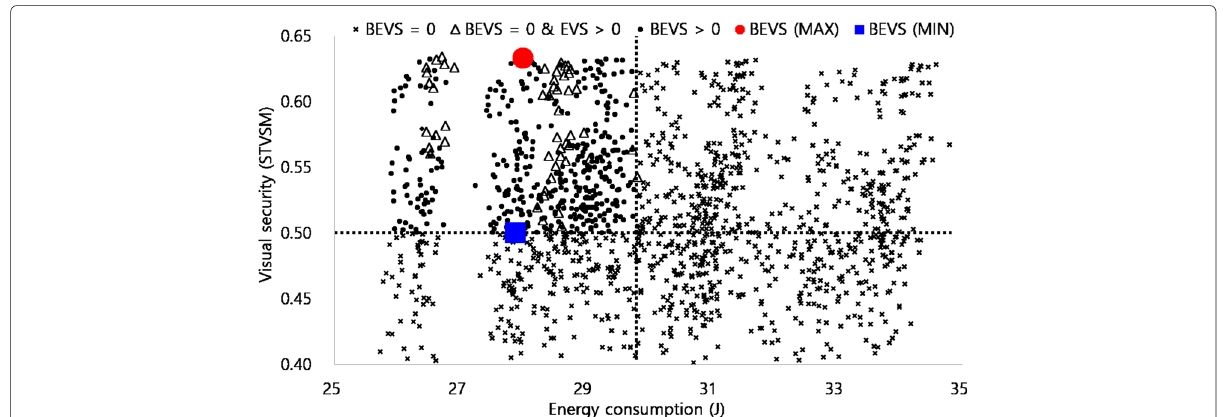
Fig. 7 Visual security enhancement through the BEVS-based design space exploration of the JVCE (Foreman video). This figure shows the design space of the JVCE which has been studied in this paper. Each dot represents the result after conducting the JVCE with one set of values of parameters. Thanks to the BEVS, we can maximize the visual security by selecting the optimal condition of the maximum BEVS instead of the one of the minimum BEVS while satisfying the requirements of the visual security, the compression bitrate, and the energy consumption